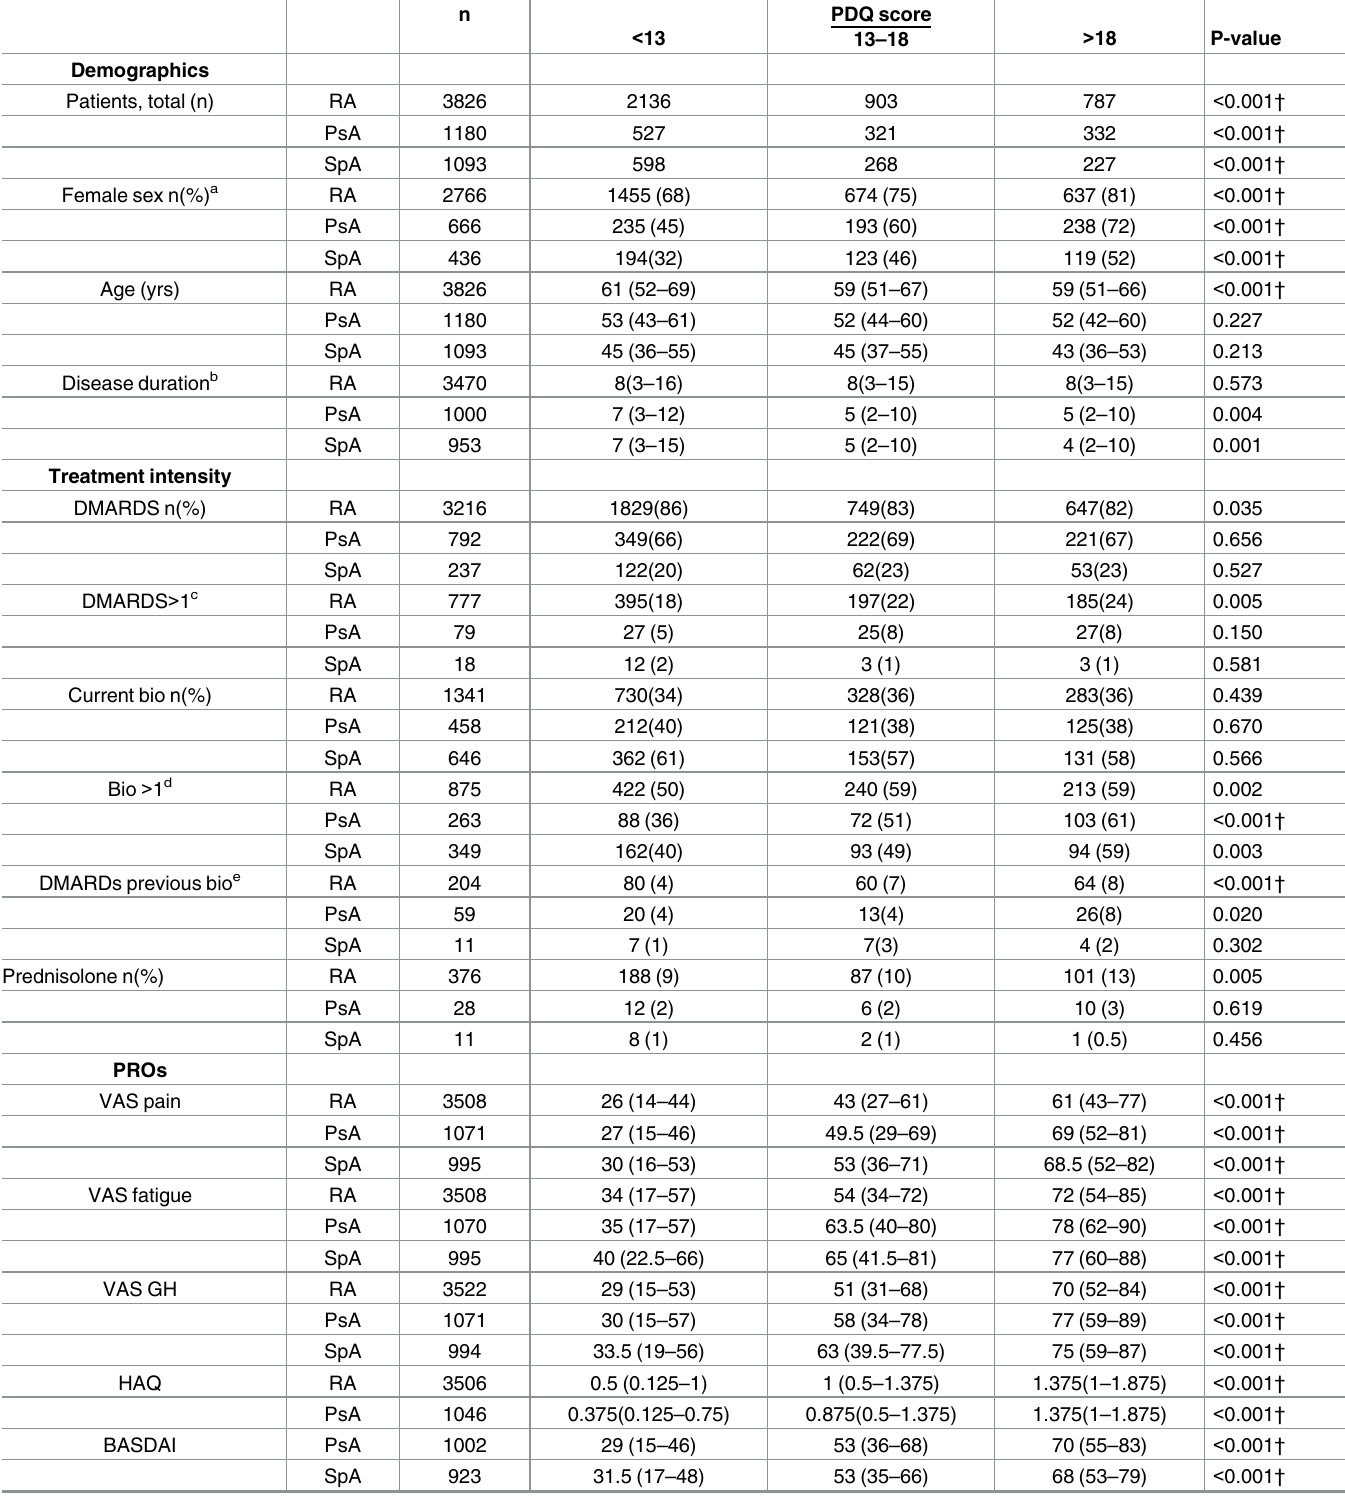
Table 2. Patient characteristics stratified by painDETECT